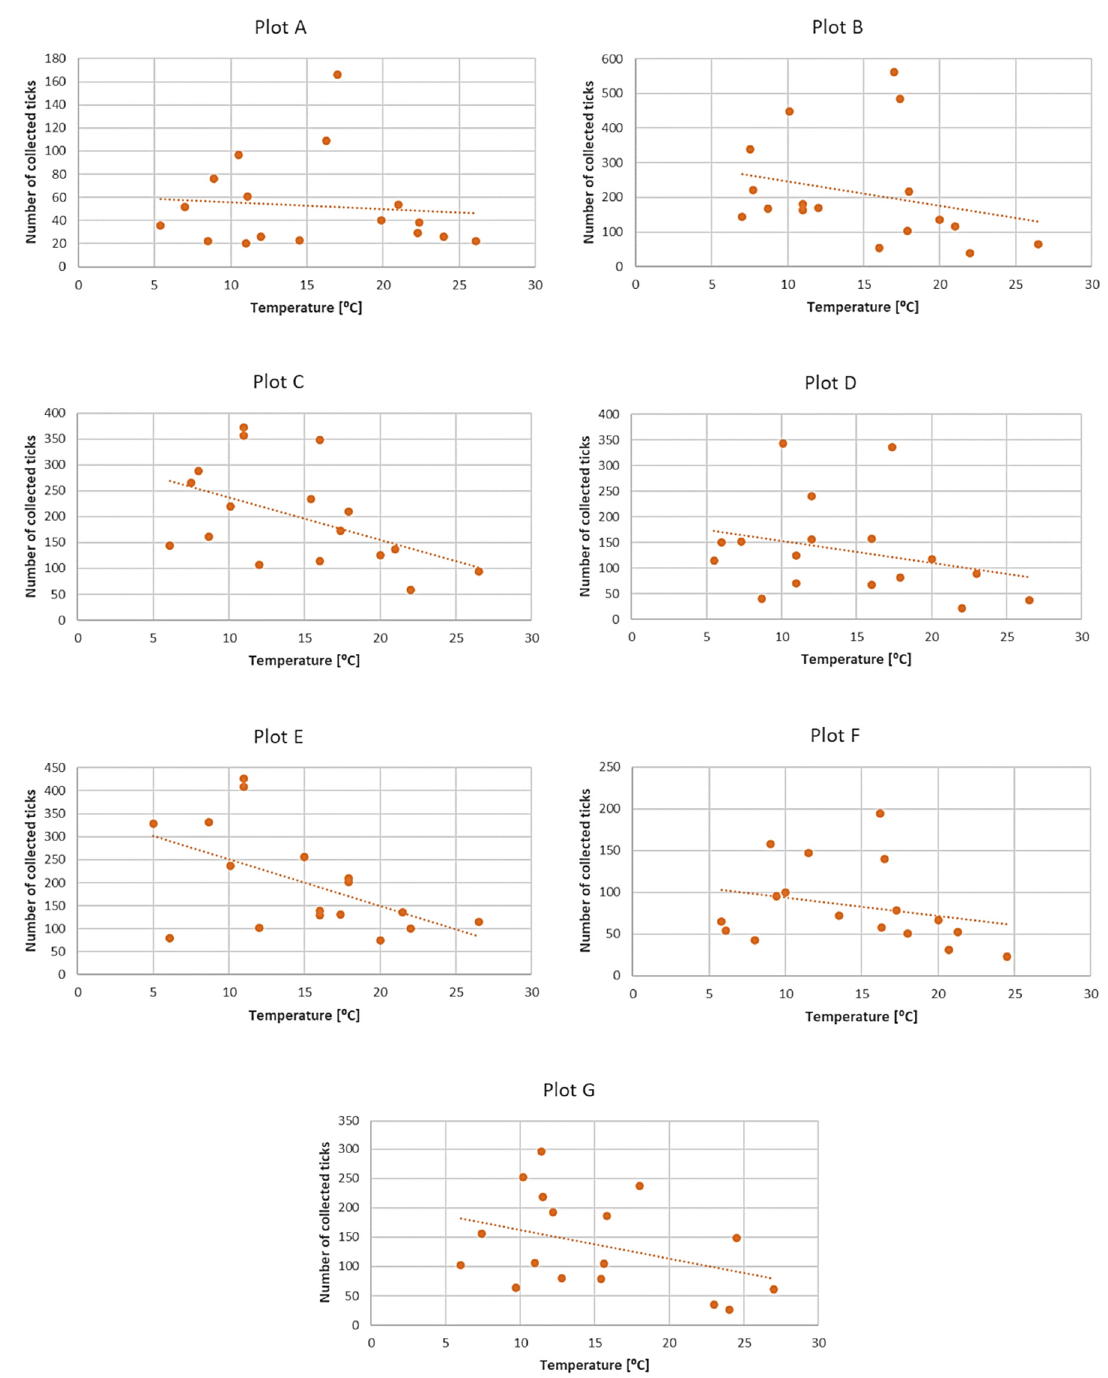
Figure 10. Relationship between air temperature and the number of active Dermacentor reticulatus adults in the research plots.